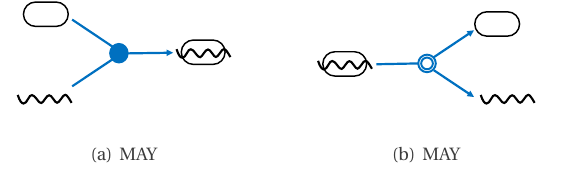
Figure 20: Examples of use of interaction nodes: (a) association of gRNA and Cas9 into an active CRISPR complex and (b) the dissociation of that complex.